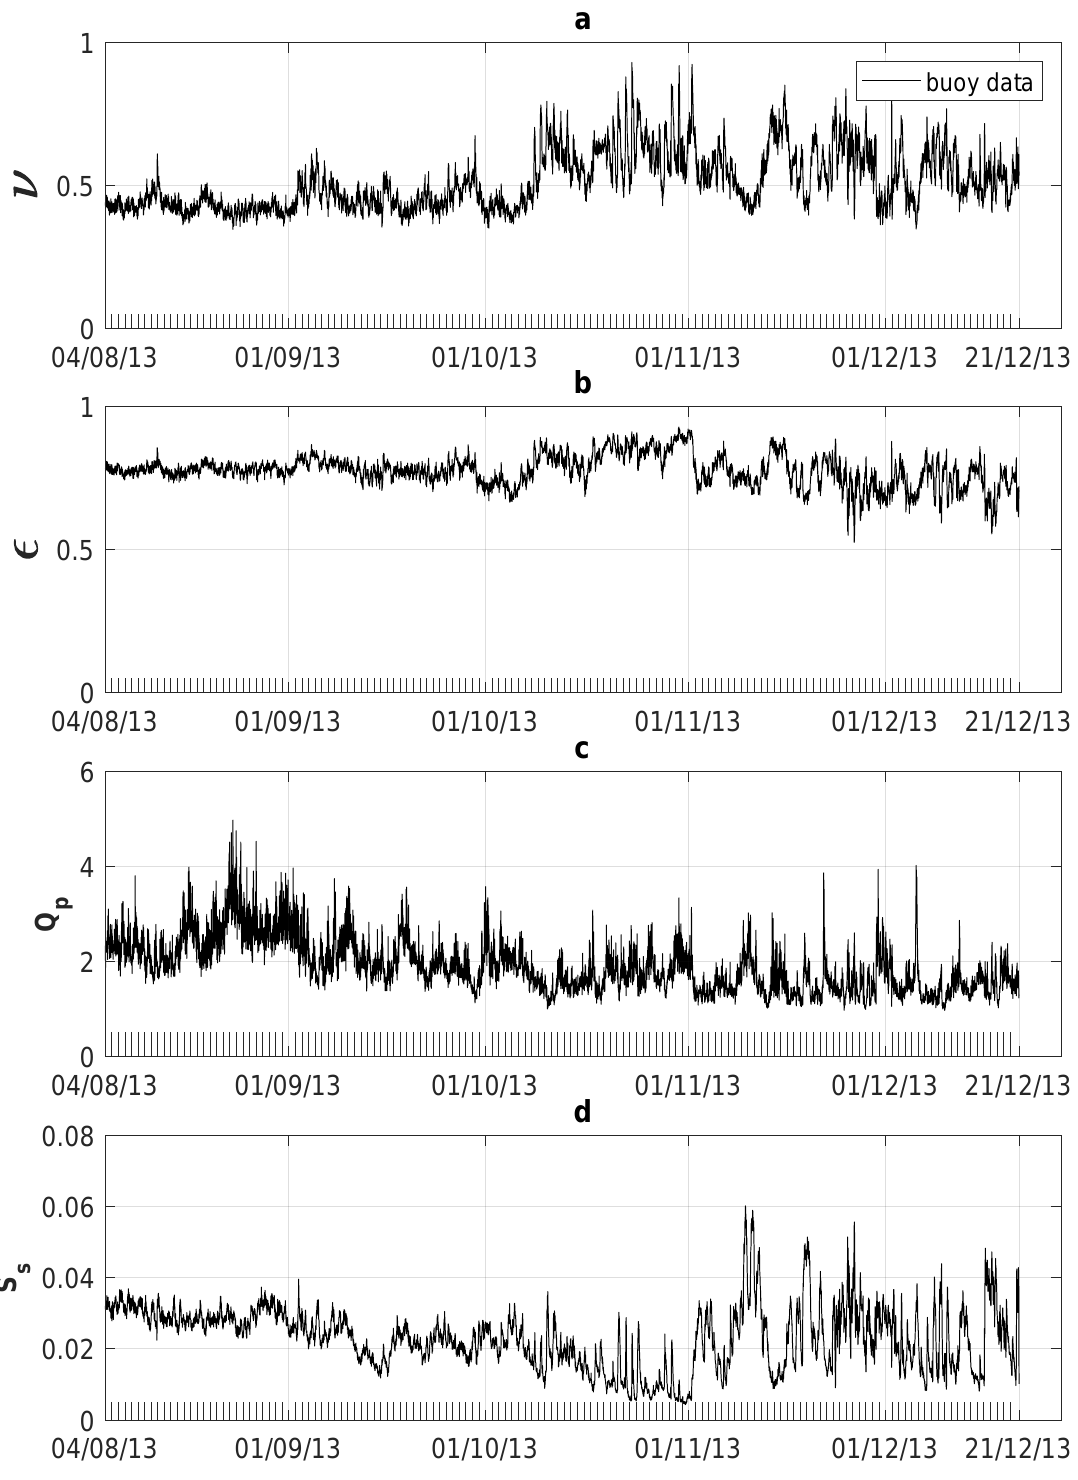
Figure 5. Time series plot of spectral narrowness parameter ν ( a ), spectral width parameter (cid:101) ( b ), spectral peakedness Q p ( c ) and significant wave steepness S p ( d